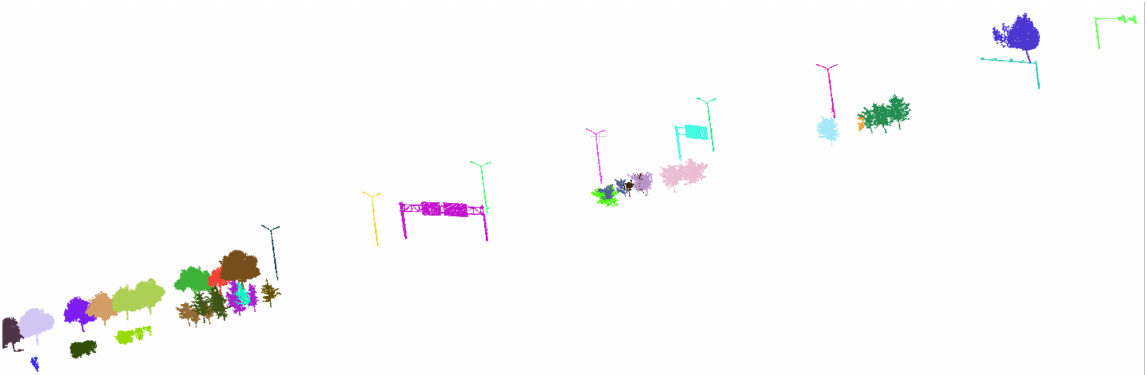
Figure 8. Euclidean clustering result. The pole-like objects are clustered according to the Euclidean metric, and each color represents a clustering